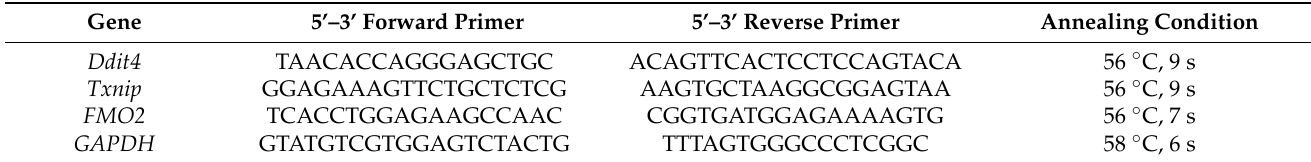
Table 1. Primers and annealing conditions used for real-time